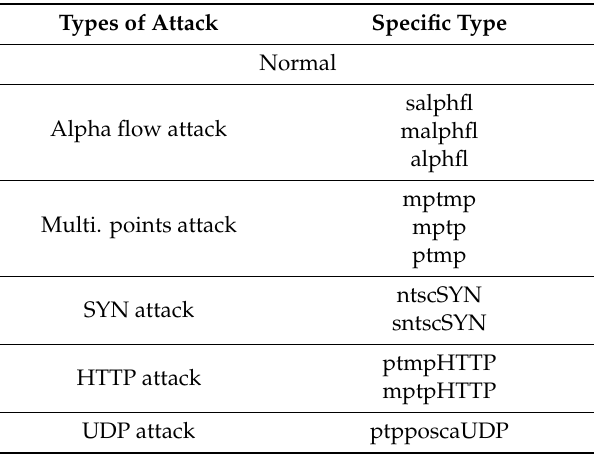
Table 2. 201710281400.pcap datasets tag list.